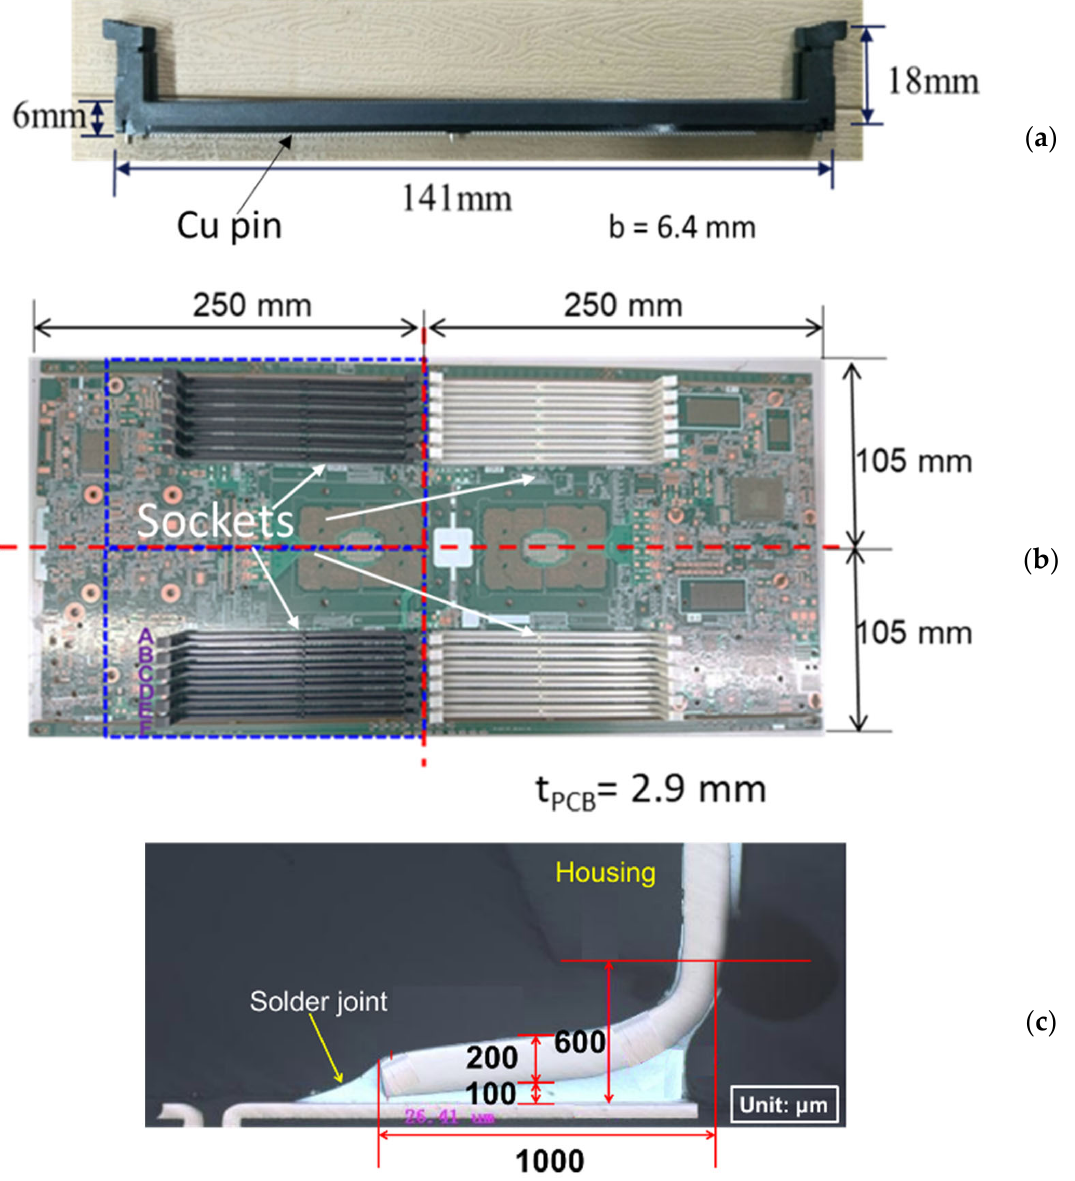
Figure 1. Configurations of ( a ) a DIMM socket with 288 Cu pins and width of 6.4 mm, ( b ) a socket- PCB assembly with 24 sockets (a full assembly), and ( c ) a detailed solder joint of a Cu pin for the DIMM socket on the PCB.